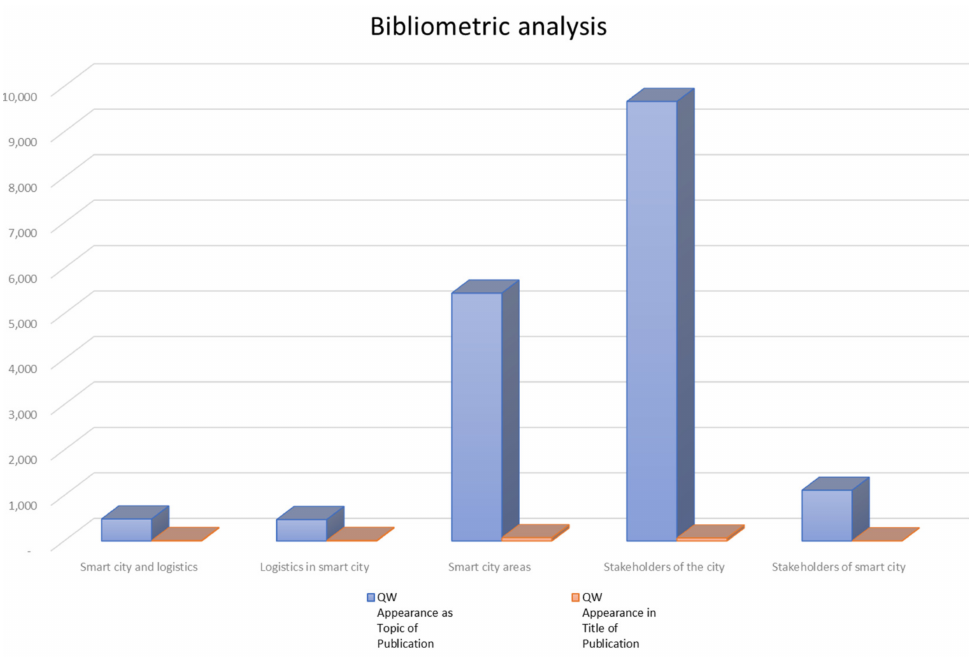
Figure 3. Bibliometric analysis of the